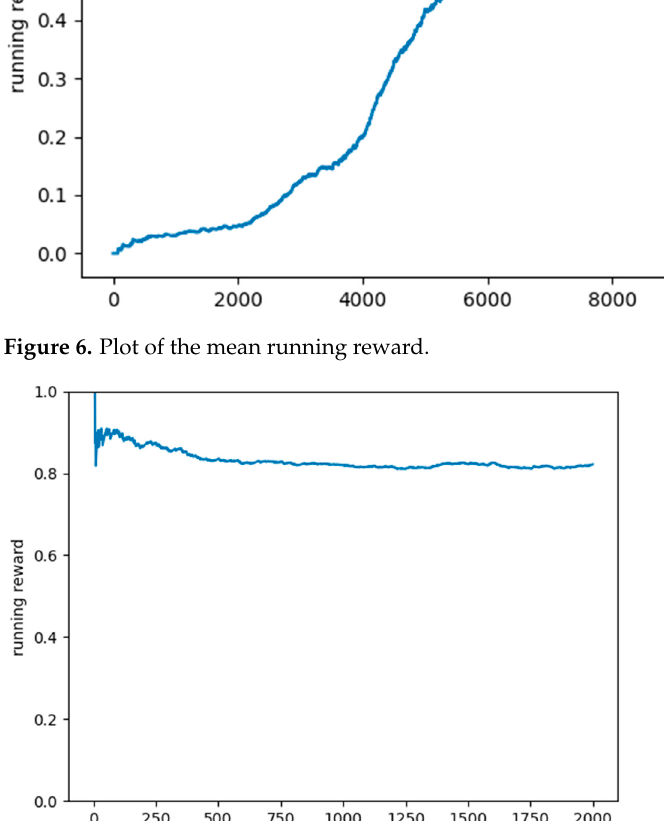
Figure 7. Plot of the mean reward on the testing